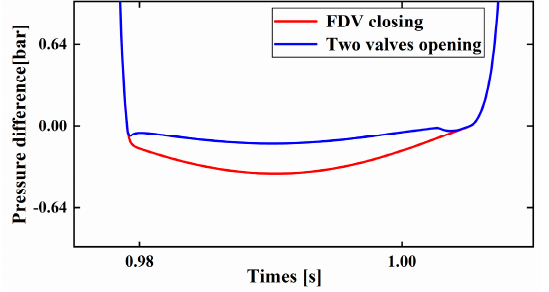
Figure 9. Pressure difference comparison of FDV closing and two valves